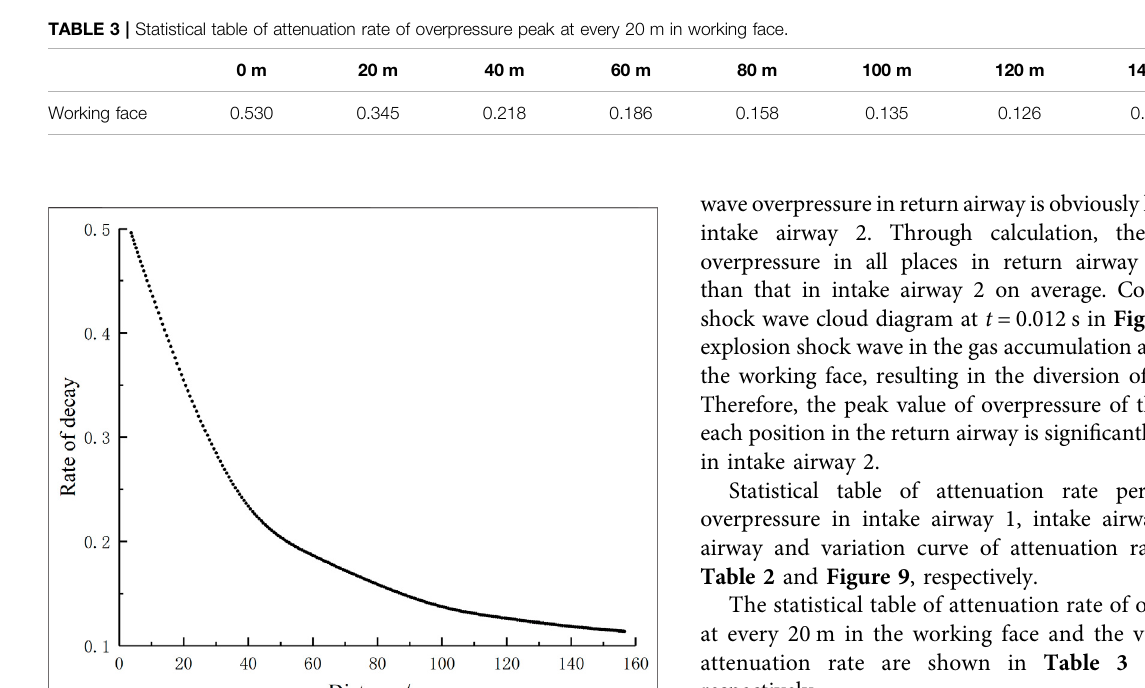
Figure 7 . The variation of overpressure peak value in intake airway 2 and return airway with distance is shown in Figure 8 .